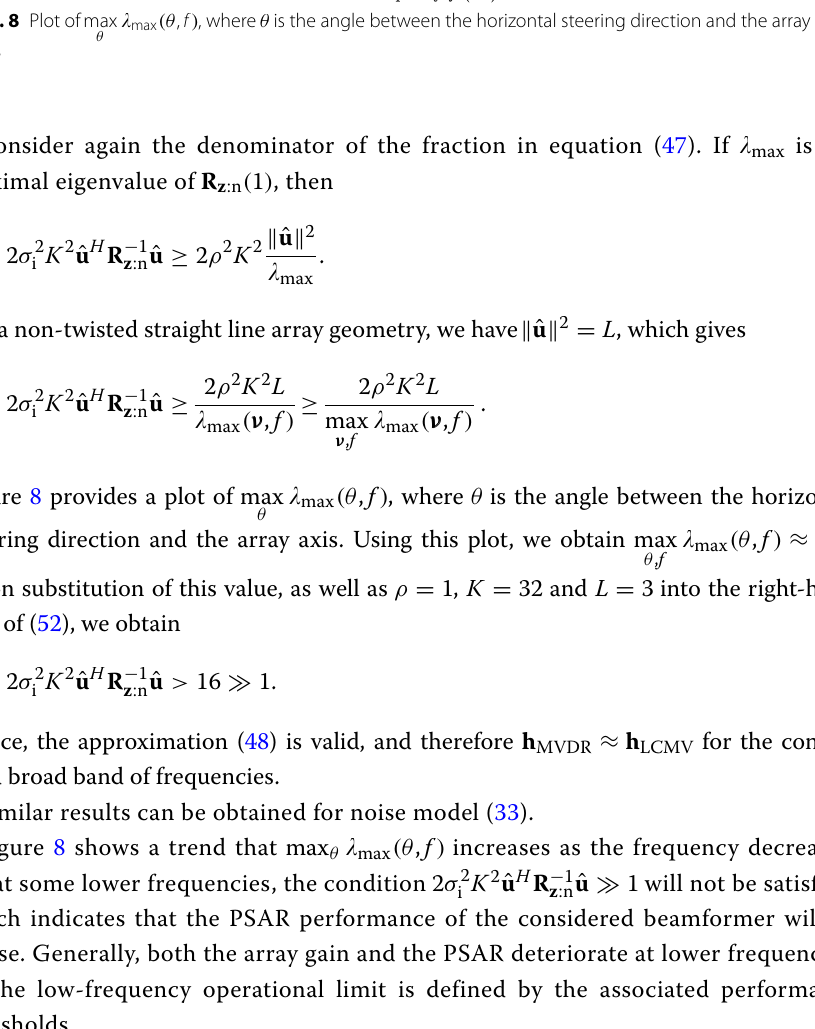
Fig. 8 Plot of max